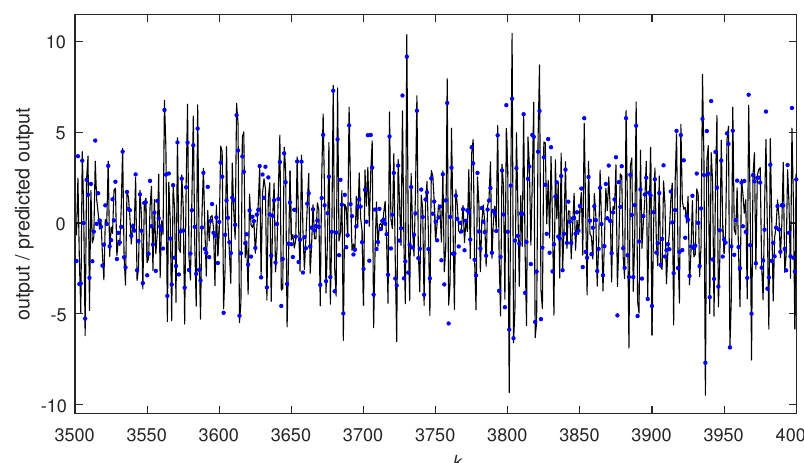
Figure 7. The predicted output ˆ y k and true output y k from k = 3501 to